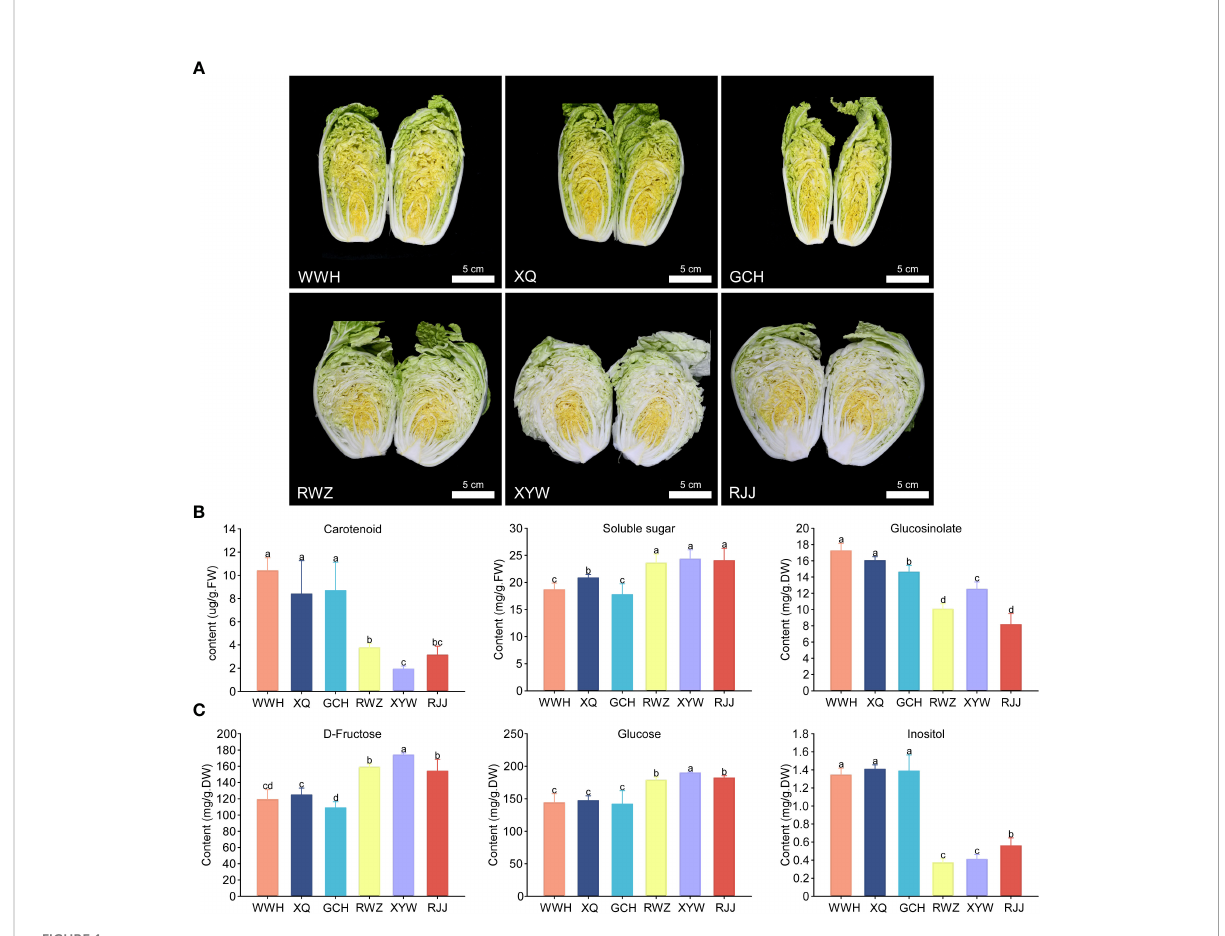
FIGURE 1 The contents of carotenoid, soluble sugar and glucosinolate in yellow and white inner-leaf Chinese cabbage. (A) the phenotype of yellow (WWH, XQ, GCH) and white (RWZ, XYW, RJJ) inner-leaf Chinese cabbage. Scale bars are 5 cm. (B) Carotenoid, Soluble sugar and Glucosinolate content. (C) D-Fructose, Glucose and Inositol content. Data are means ± SD, N = 3. Different letters indicate signi fi cant differences among six Chinese cabbage by t-tests (p ≤